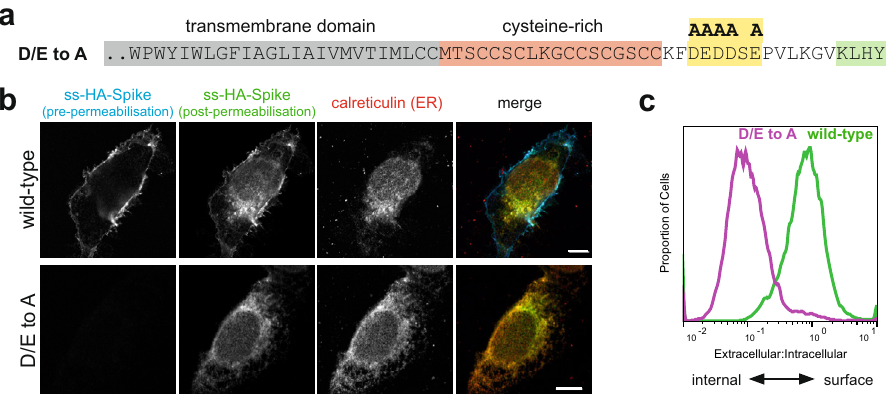
Fig. 3 The cytoplasmic tail of the SARS-CoV-2 S protein harbours di-acidic ER export motifs. a C-terminal sequence of the D/E to A mutant of S indicating the putative di-acidic ER export motifs mutated to alanine. b Micrographs of U2OS cells transiently expressing N-terminally HA-tagged wild-type S and the D/E to A mutant. Cell surface S was initially stained under non-permeabilising conditions with an anti-HA antibody labelled with Alexa Fluor (AF) 647. Cells were then permeabilised and stained with anti-HA labelled with AF488 to detect the internal S. Scale bars 10 μ m, with the images for the individual channels taken at the same magni fi cation as the merged image that has the scale bar. The experiment was repeated twice. c Quanti fi cation of ( b ) by fl ow cytometry. Displayed are overlaid histograms representing the ratio of extracellular S (AF488 signal) to that of intracellular S (AF647 signal) for wild-type S and the D/E to A mutant. Histograms normalised to the mode value, and represent >10,000 events. Chi-squared test shows the difference in the median ratios (wild-type, 0.78; D/E > A, 0,096) to be statistically signi fi cant ( P = 0.01, 99% con fi dence). Representative of six independent